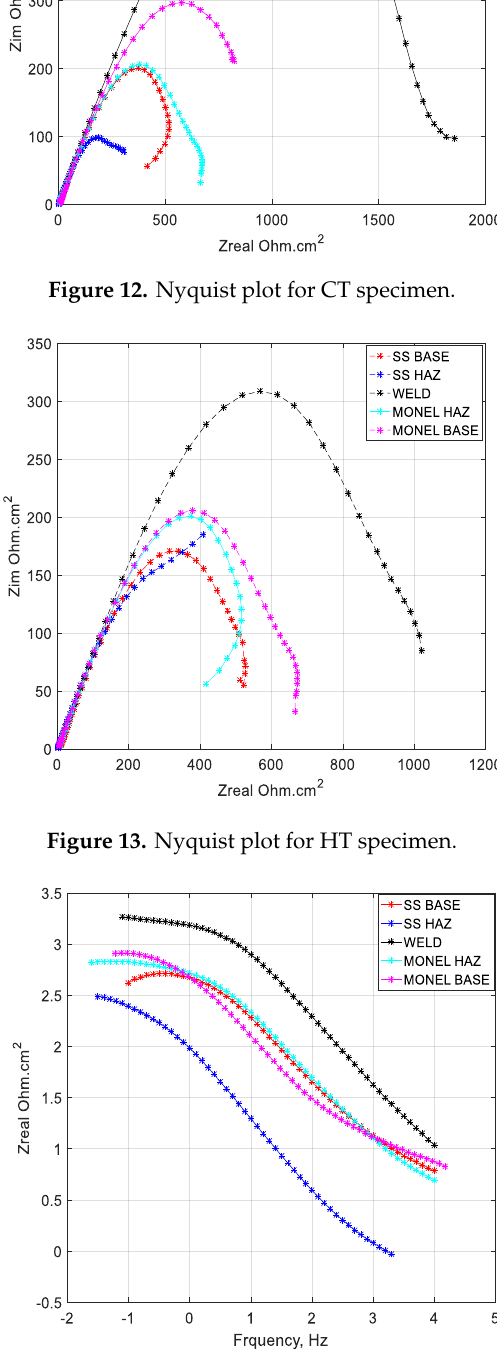
Figure 15. Bode plot for HT specimen. Figure 16. Phase angle variation for CT specimen.